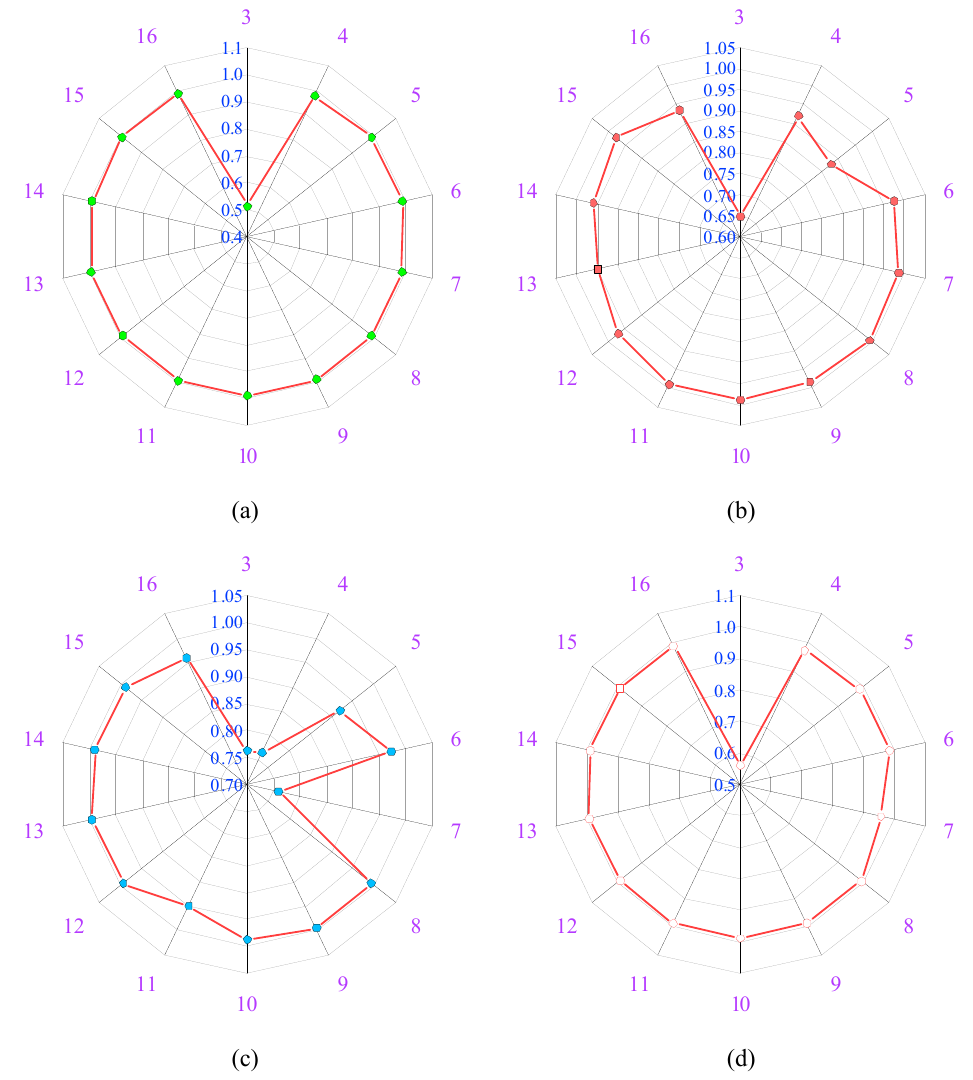
Figure 5. Values of R for each neuron; ( a ) training dataset, ( b ) validation dataset, ( c ) testing dataset, ( d ) overall dataset.